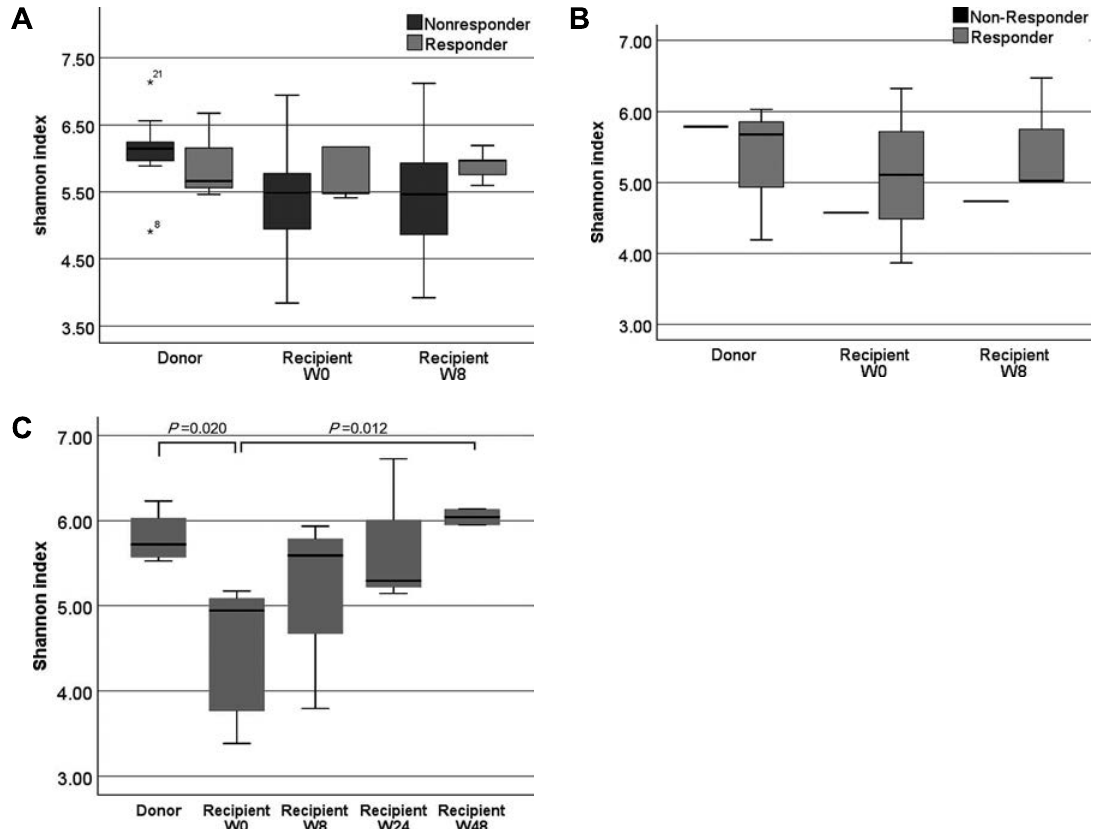
Figure 2 Fecal microbiota alpha diversity (Shannon index) in patients before and after fecal microbiota transplantation compared with that in healthy donors. The ends of the box represent the upper and lower quartiles, the horizontal line inside the box represents the median, and the whiskers represent the highest and lowest levels. Statistical analysis was performed using the Mann–Whitney U test. A. Ulcerative colitis. B. Crohn’s